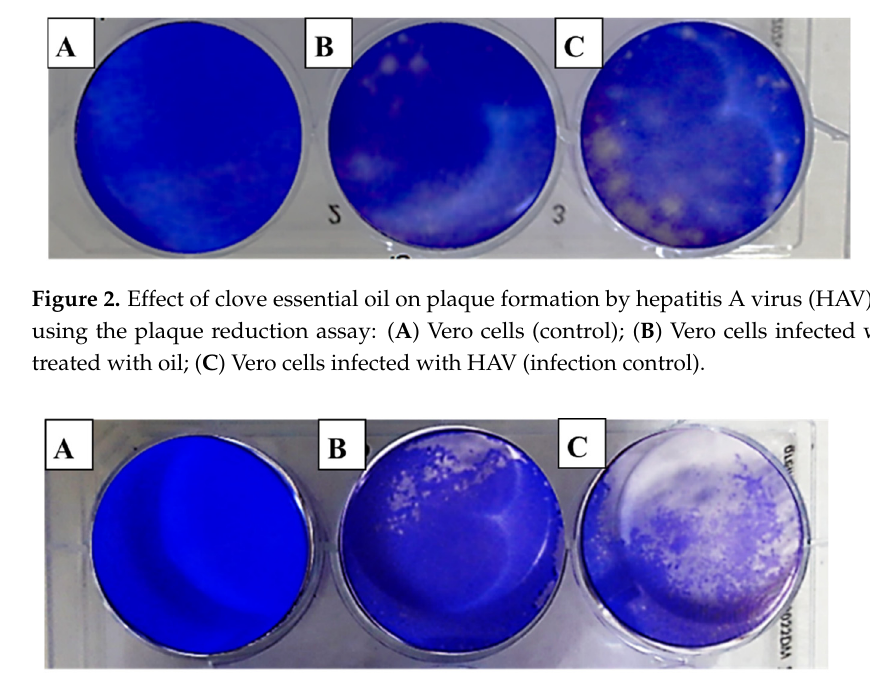
The outcomes are presented as the mean ± standard deviation (SD). effects; SI = CC 50 /IC 50 ; NA: no activity; SD: standard deviation.